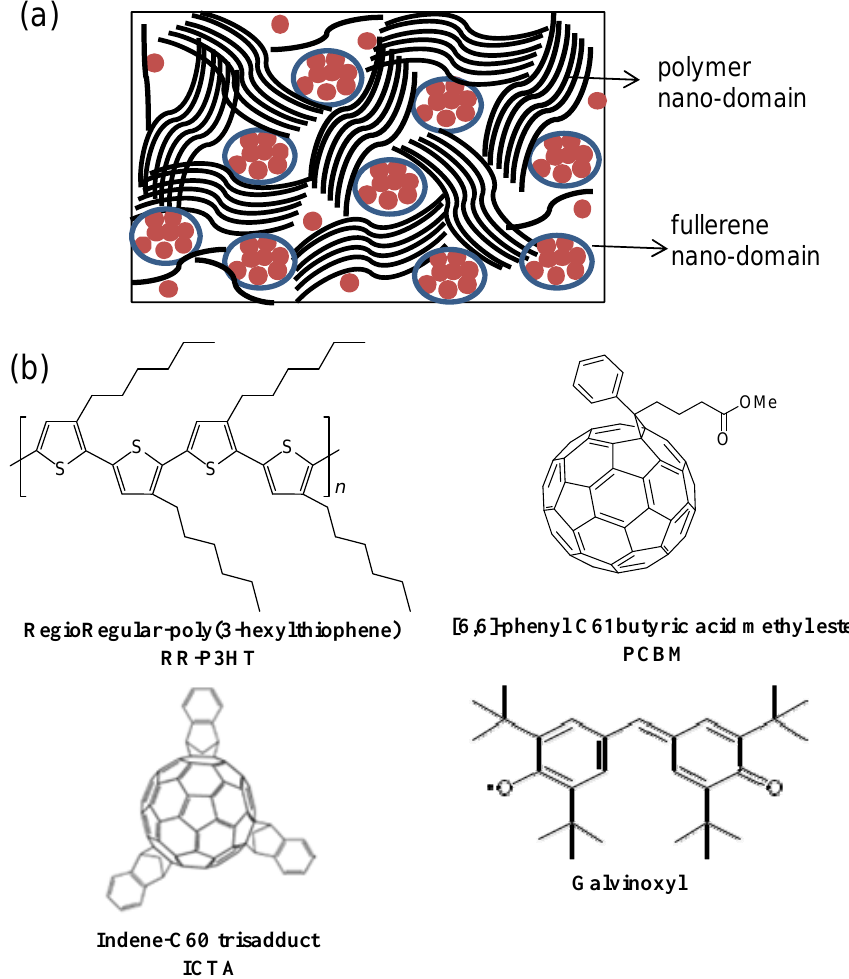
polymer nano-domain